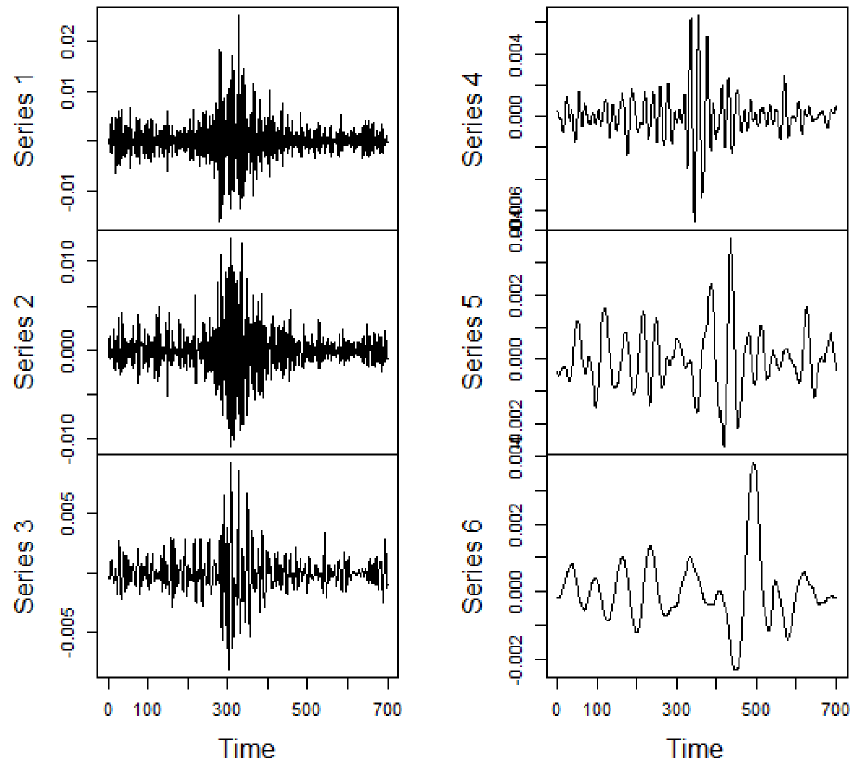
Figure 5. Daily wavelet coefficients of S&P500 during sub-prime crisis period. Series n refers to Wavelet level n or 2 n-1 trading days.